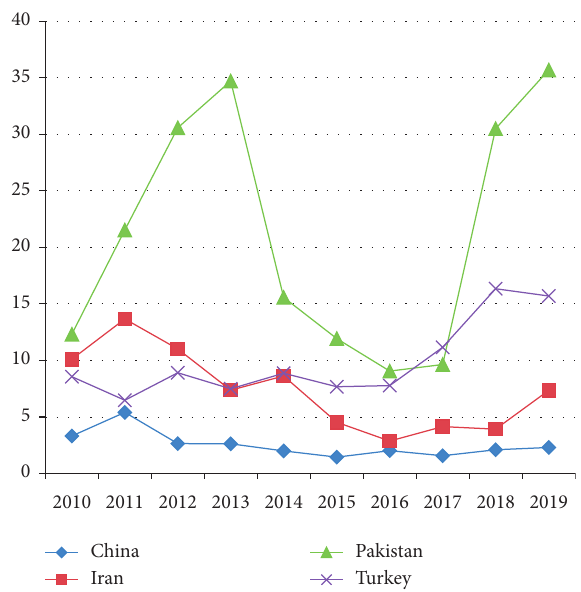
Figure 5: The inflation rate of four countries from 2010 to 2019. Source: World Economic Outlook (April 2021).